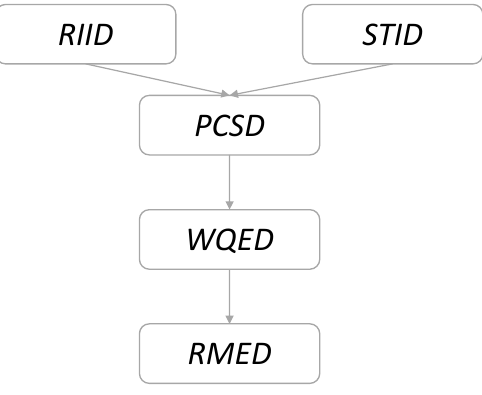
Figure 7. Convergent + serial relationship.